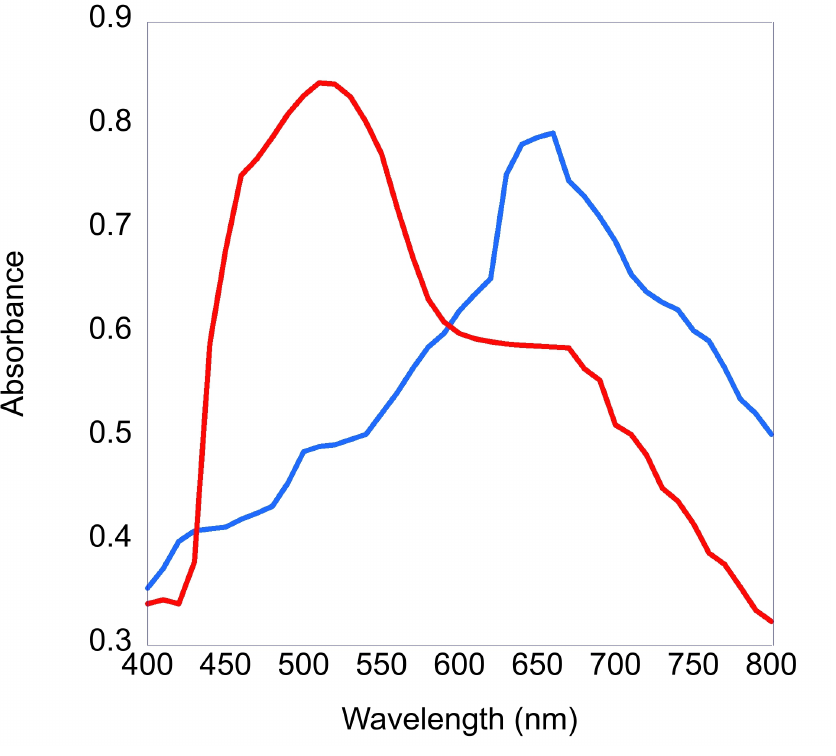
Figure 2. Absorbance of red and blue microspheres shown in red and blue traces, respectively.